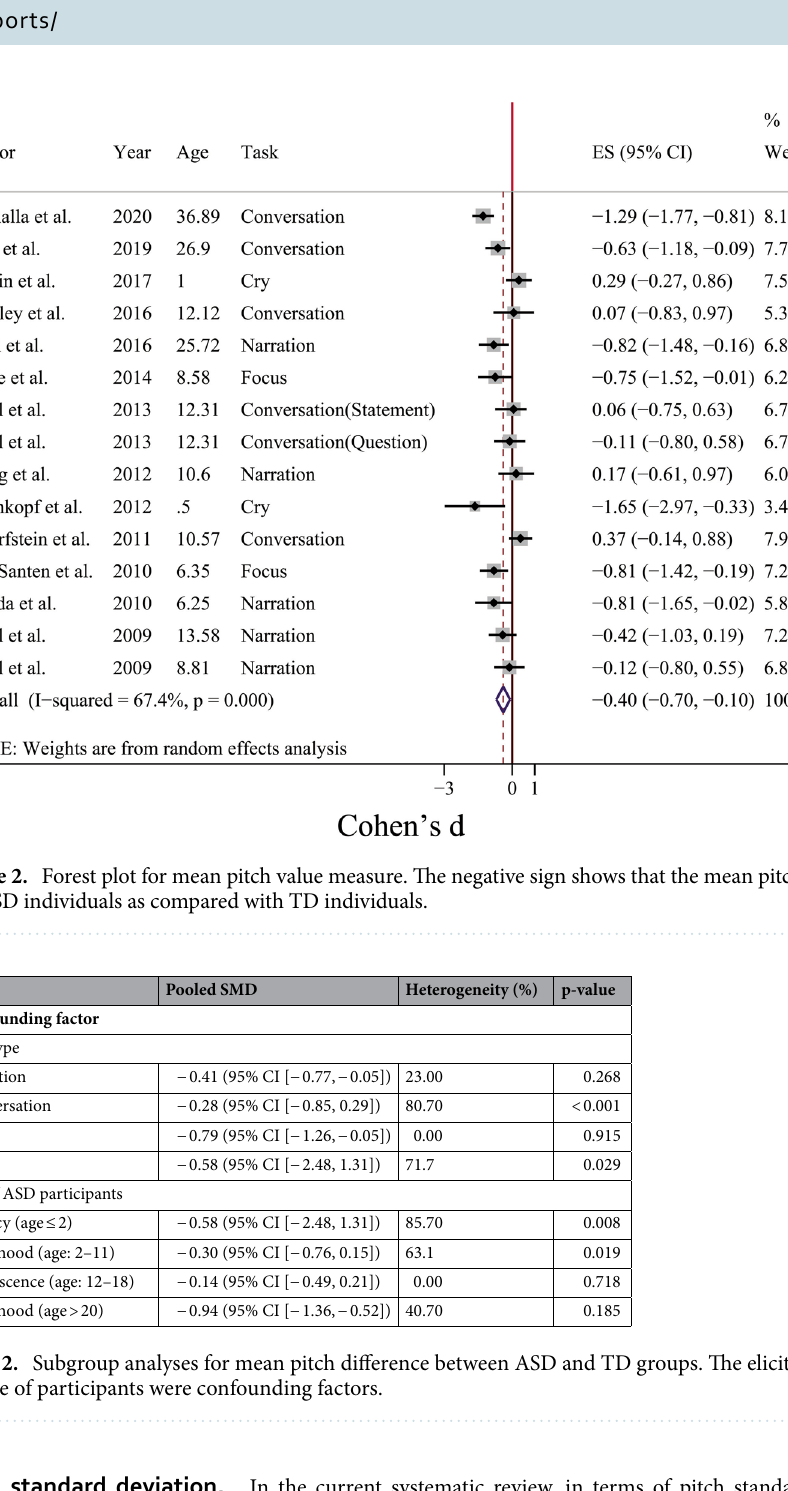
Table 2. Subgroup analyses for mean pitch difference between ASD and TD groups. The elicitation tasks and the age of participants were confounding factors.